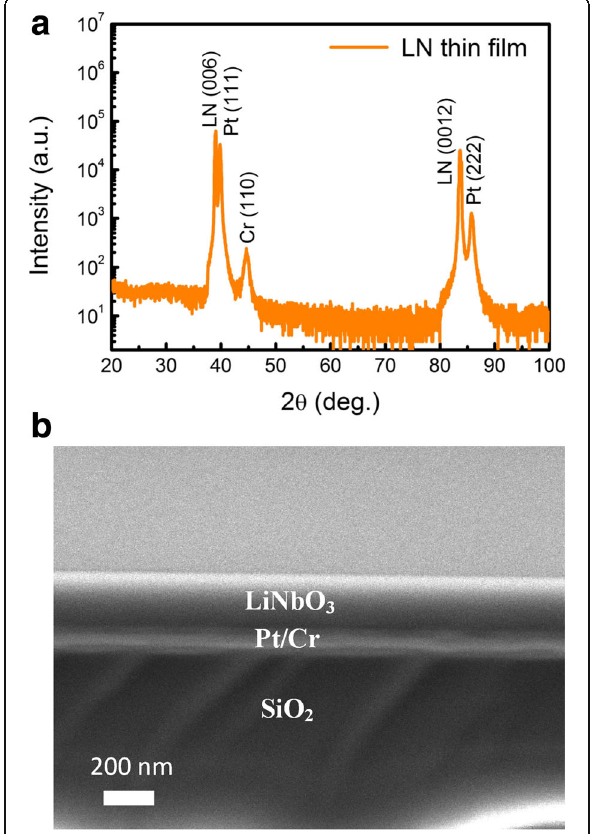
Fig. 1 a The XRD pattern and b cross-section SEM image of the Z- cut 200-nm-thick LN/Pt/Cr/SiO 2 /LN